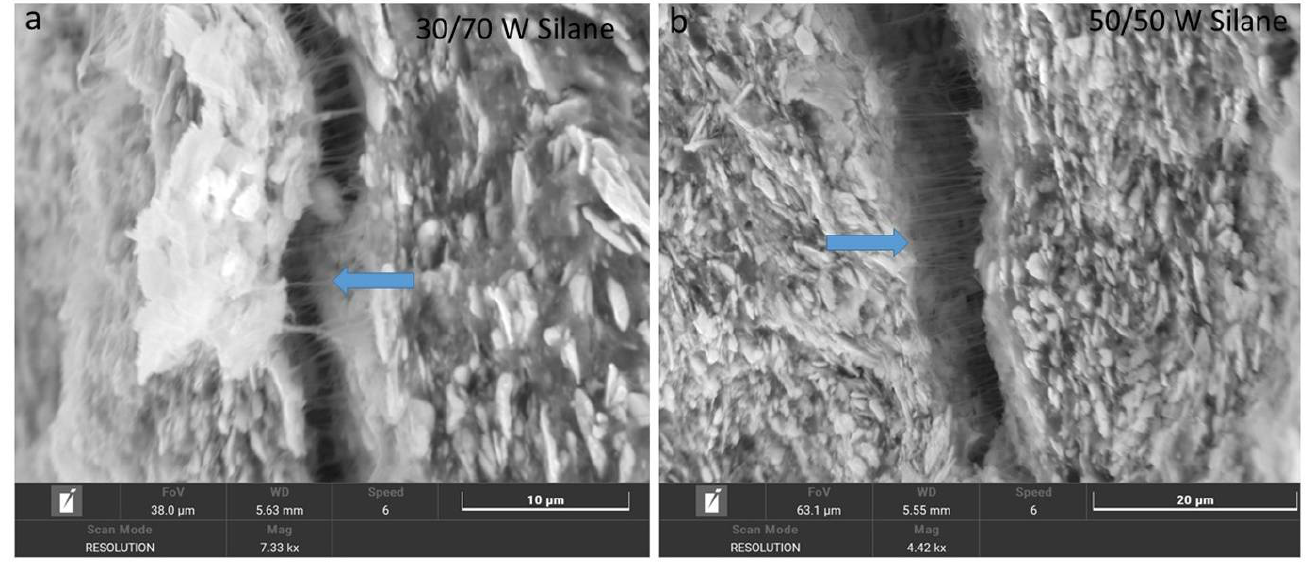
Figure 4. SEM images of ( a ) 30/70 composite (silane), ( b ) 50/50 composite (silane).